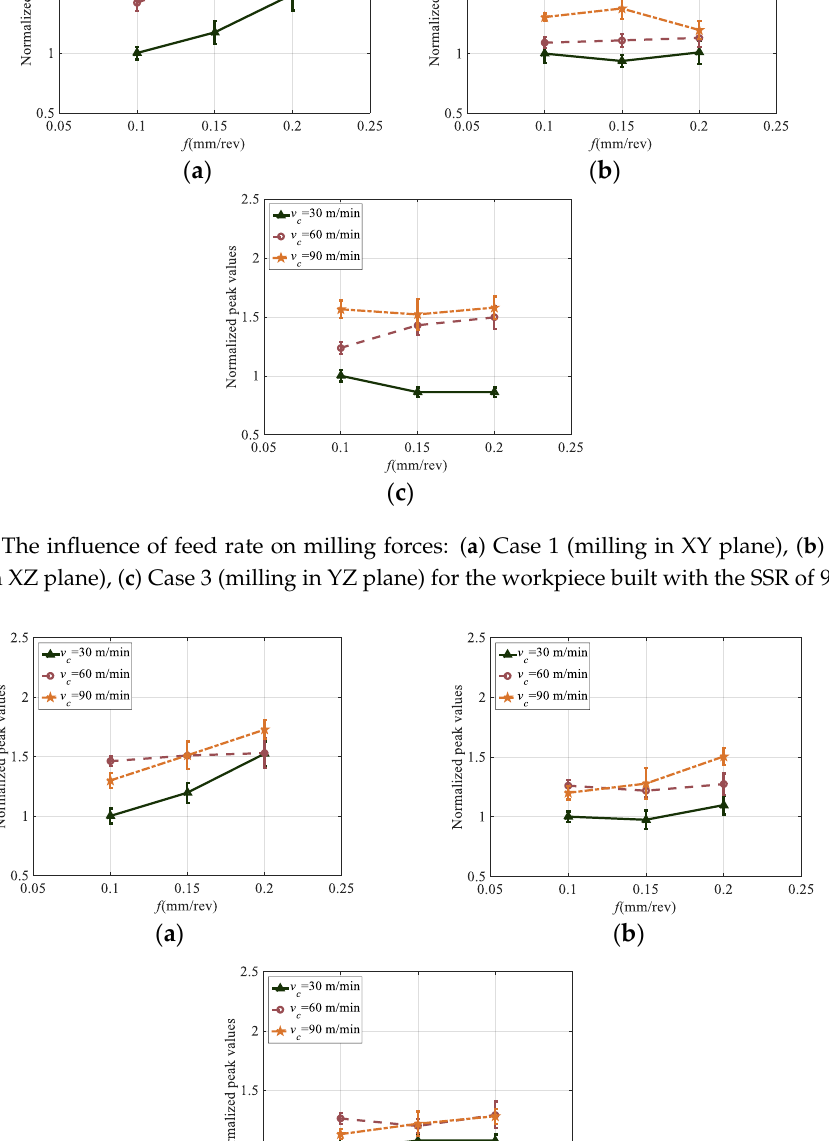
from 0.1 mm / tooth / rev to 0.2 mm / tooth / rev ( v c = 90 m / min and milling in the XZ plane as shown ( v c = 30 m / min and milling in YZ plane as shown in Figure 8c) for the workpiece built with the SSR ◦ of 90